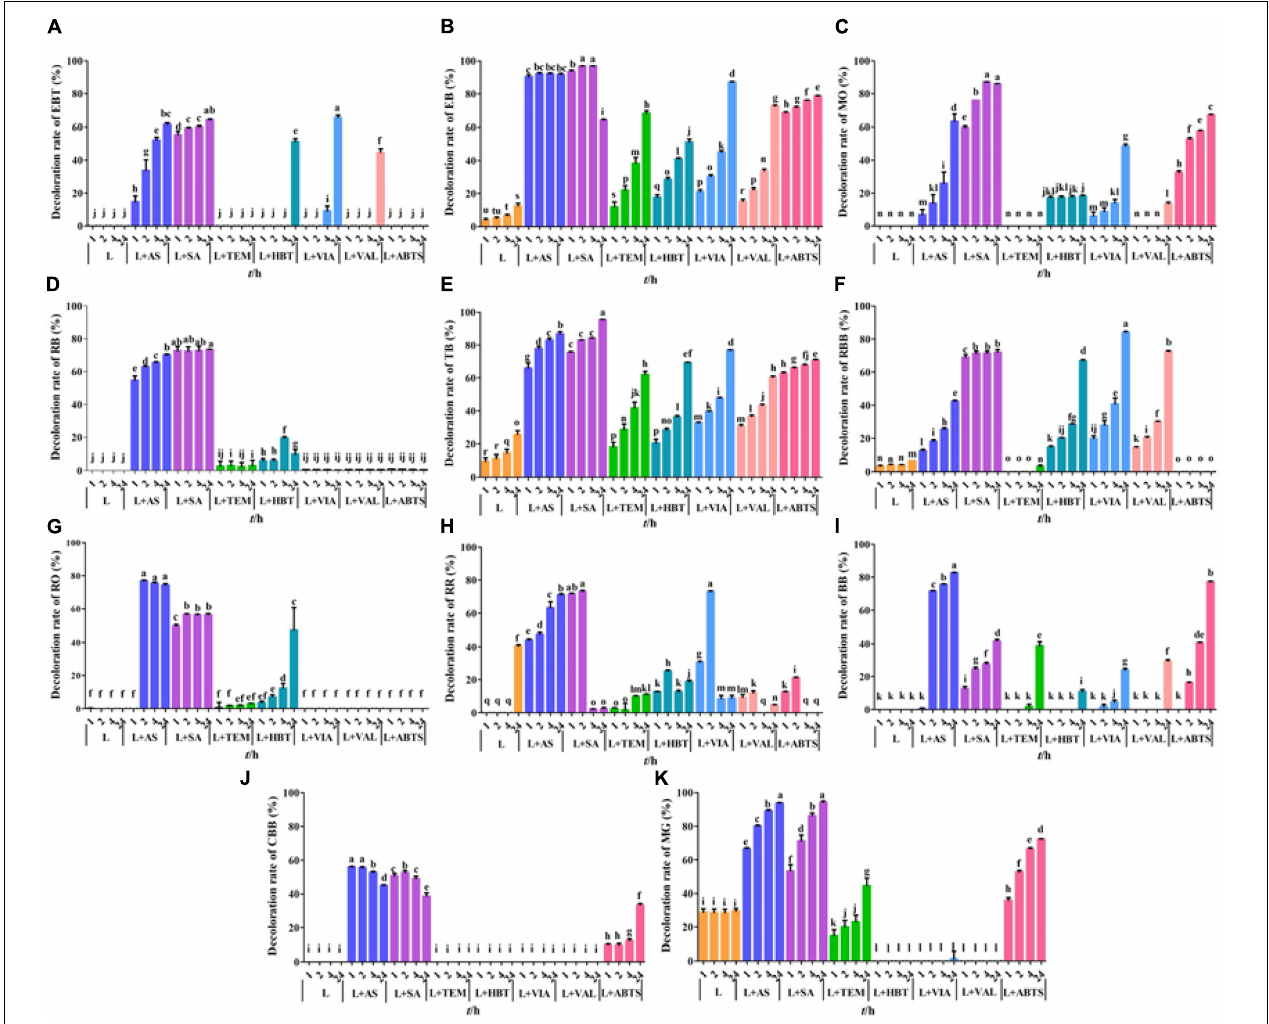
FIGURE 4 | Dye decolorization by LMS. (A) eriochrome black T (EBT); (B) Evans blue (EB); (C) methyl orange (MO); (D) reactive black (RB); (E) trypan blue (TB); (F) reactive brilliant blue (RBB); (G) reactive orange (RO); (H) reactive red (RR); (I) bromophenol blue (BB); (J) Coomassie brilliant blue G250 (CBB); (K) malachite green (MG). L, free laccase; AS, acetosyringone, SA, syringaldehyde; TEMPO, 2,2,6,6-tetramethylpiperidine 1-oxyl; HBT, 1-hydroxybenzotriazole; VIA, violuric acid; VAL, vanillin; ABTS: 2,2 (cid:48) -azino-bis (3-ethylbenzothiazoline-6-sulfonic acid). The letters denoted the statistical significance according to the Tukey test at P < 0.05.